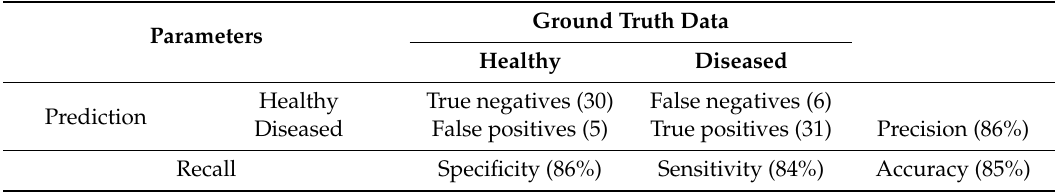
Table 2. Example of a confusion matrix, based on data for an ortho scene collected on July 3, 2017, computed to evaluate the performance of random forest trained models in detecting healthy and sudden death syndrome infected soybean quadrats. Disease “negative” and “positive” classes refer to quadrats that are healthy or diseased, respectively.